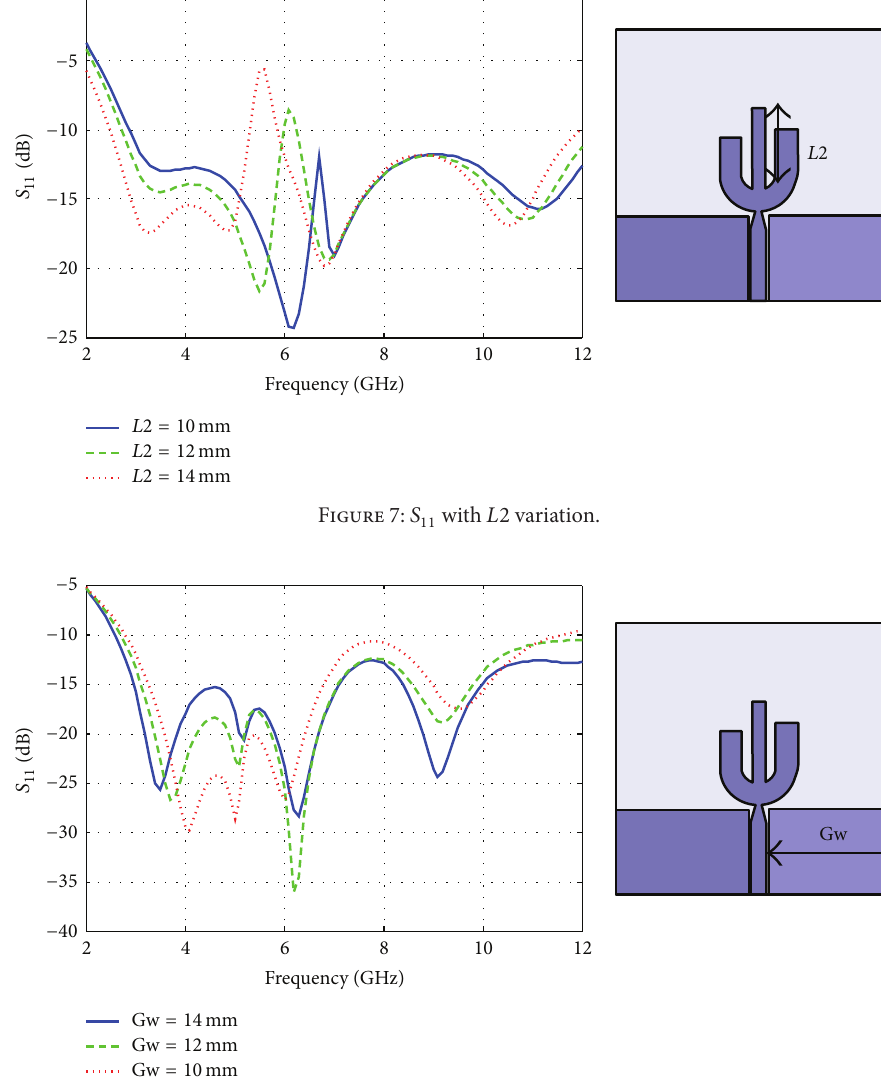
Figure 8: 𝑆 11 with ground width (Gw)